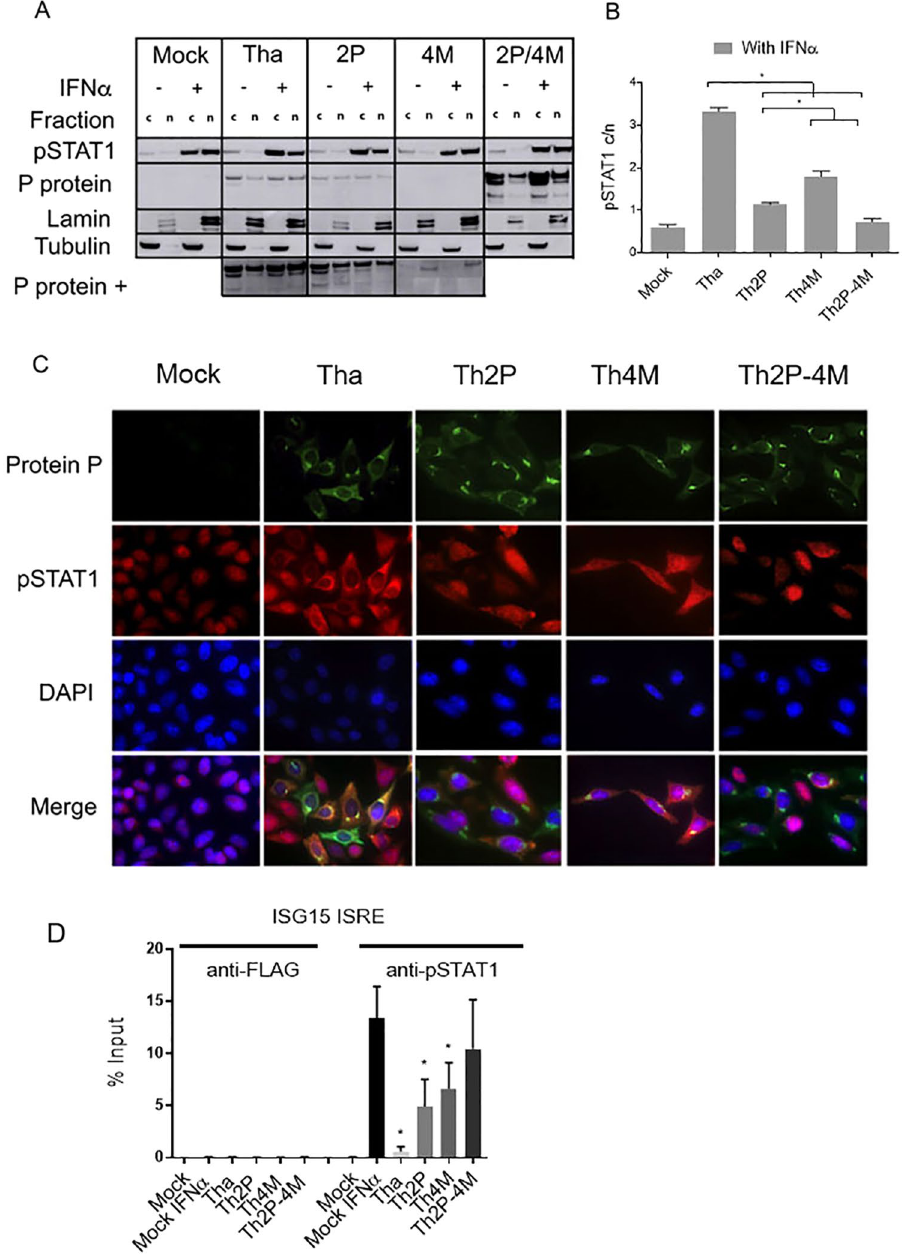
Figure 3. RABV P and/or M proteins are involved in pSTAT1 cytoplasmic retention. ( A ) After cytoplasmic and nuclear fractionation of HeLa cells infected with wild-type (Tha) or P- and/or M-mutated–protein RABVs (Th2P, Th4M, Th2P-4M) and stimulated with IFN α (1000 U/mL, 24 h) or not, the presence of P and pSTAT1 protein was analysed by immunoblotting with specific antibodies. Lamin and tubulin served as controls. Abbreviations, c: cytoplasmic fraction, n: nuclear fraction. ( B ) pSTAT1 cytoplasm/nucleus quantification based on three independent experiments, expressed as means ± standard deviation (T-bars)). * p < 0.05. ( C ) Specific antibody immunolabeling of pSTAT1, and P and M proteins in cells infected with different recombinant RABVs. DAPI was used to stain nuclei blue. ( D ) HeLa cells were infected with wild-type (Tha) or Th2P, Th4M, Th2P-4M. After 24 h of infection, IFN α (1000 U/mL, 24 h) was added. ChIP assays were run with the indicated antibodies. ChIP DNA was analyzed by qPCR by using ISG15-ISRE primers. Results are expressed as the means ± standard deviation (T-bars) of three independent experiments. * p <